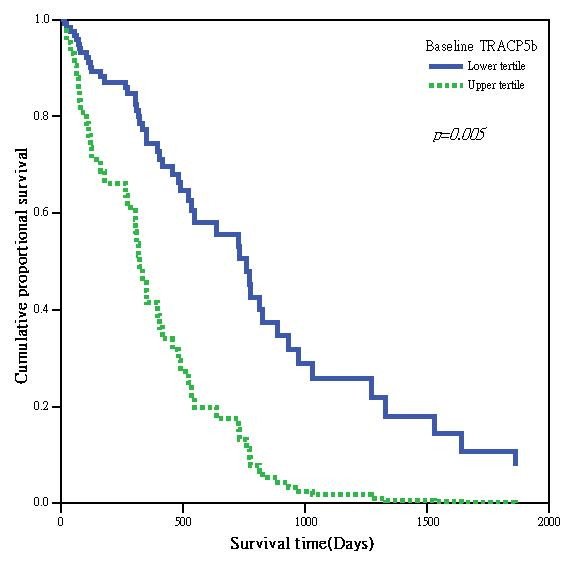
Survival curve comparing patients with baseline TRACP 5b activity in the upper third and the lower two thirds using Cox-regression model.